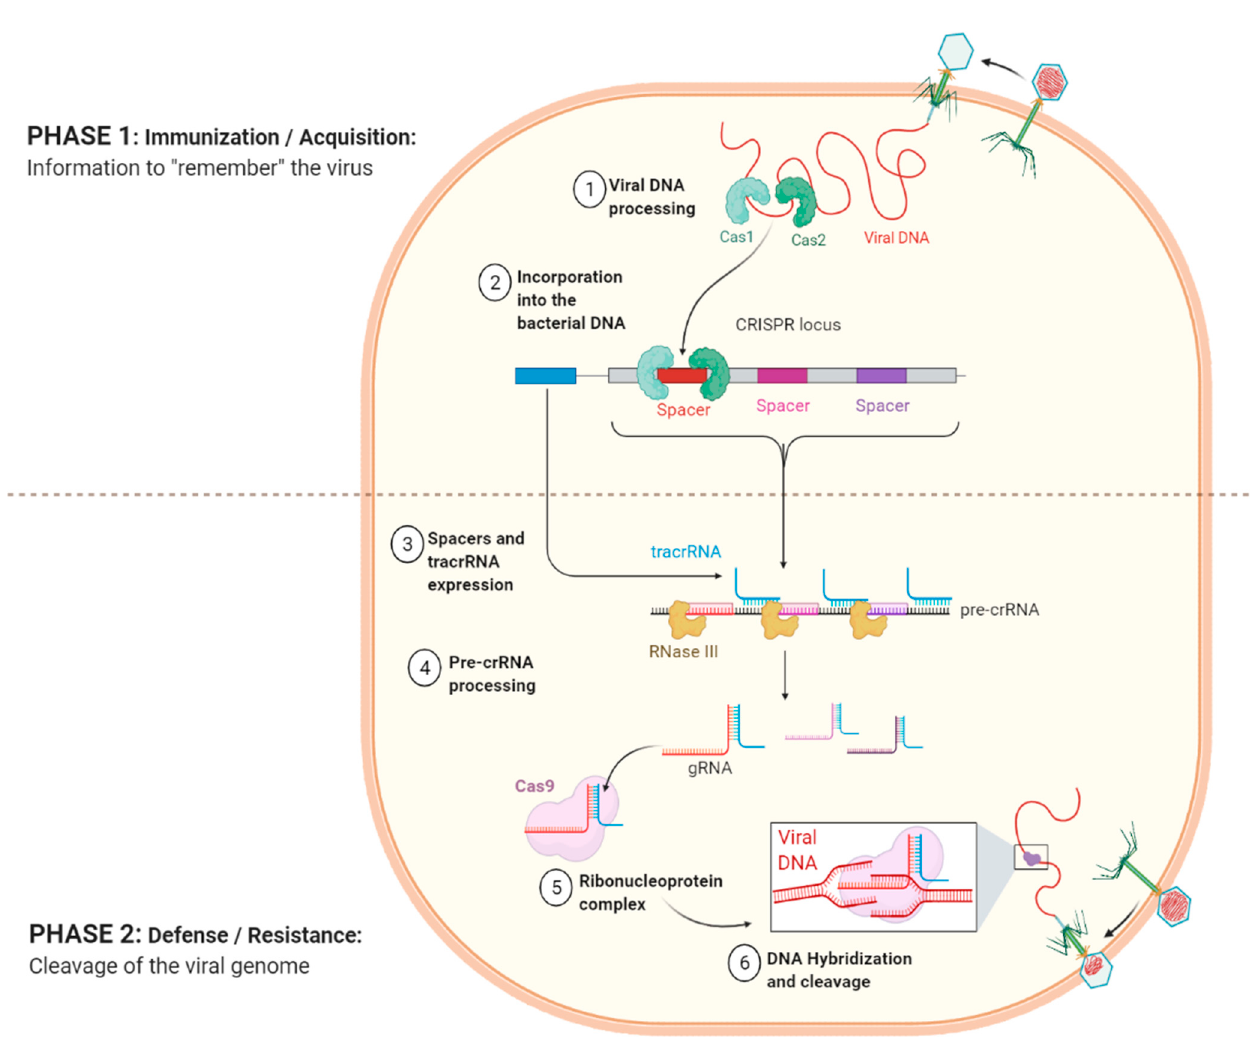
Figure 3. CRISPR-Cas9 Adapative Immune System of Pseudomonas aeruginosa against bacteriophage